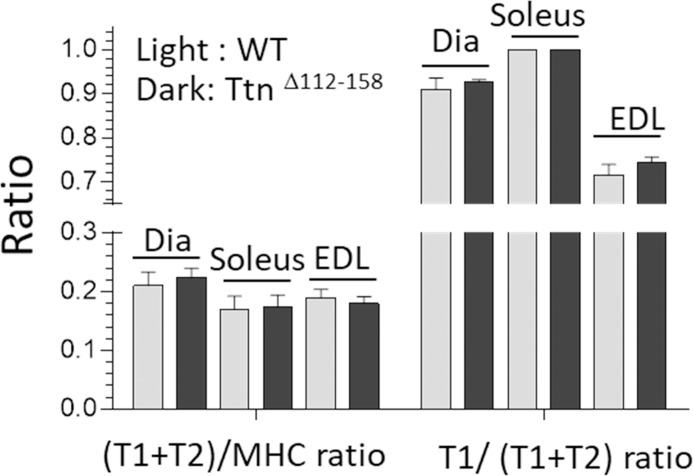
Titin expression analysis.The total amount of titin, T1 + T2 (relative to myosin heavy chain, MHC) and the fractional content of T1 (relative to total titin) are unaltered in the Ttn∆112-158 mice.